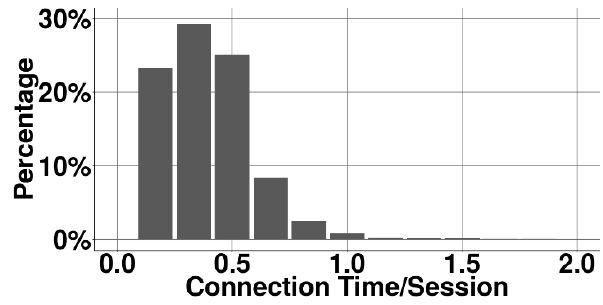
Figure 6. Distribution of connection times at fast charging stations per 10 min.